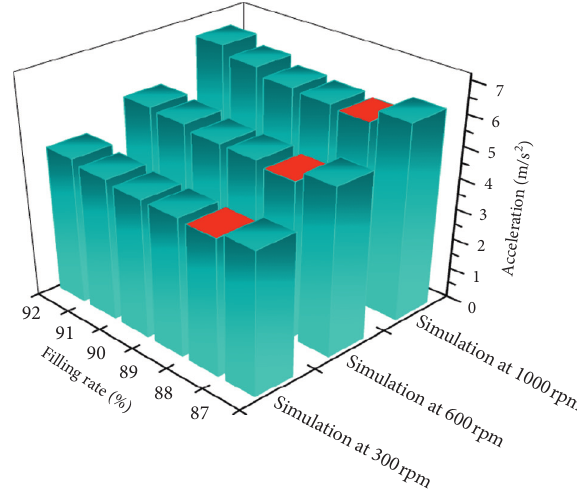
Figure 13: Effect of refining the filling rate.